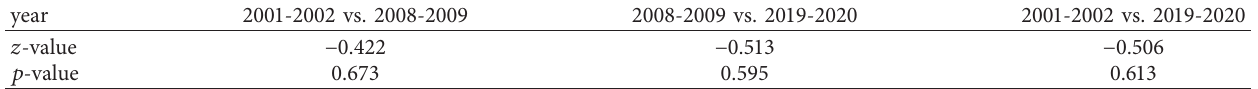
Table 1: Results for Wilcoxon’s signed rank test of Chinese RSCA index.